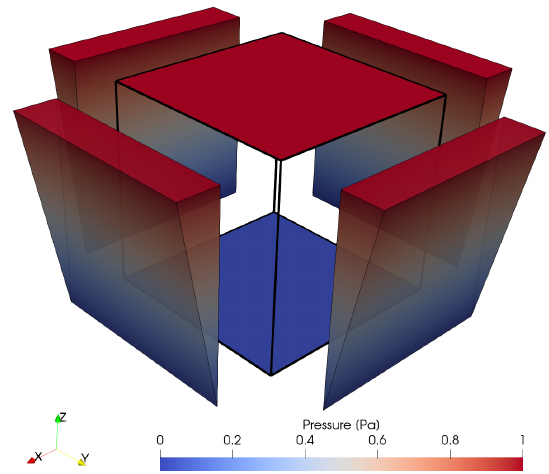
Figure A1. Pressure boundary conditions for an applied gradient in the z direction. Here, top and bottom faces experience constant pressures of 1 and 0Pa, respectively. A linearly interpolated pres- sure distribution is applied at the remaining four boundary faces, as indicated by the colored wedges next to the side faces of the model. Thus, the principal direction of flow is in the z direction, allowing for the calculation of the terms related to the z component of the permeability tensor according to Eq.